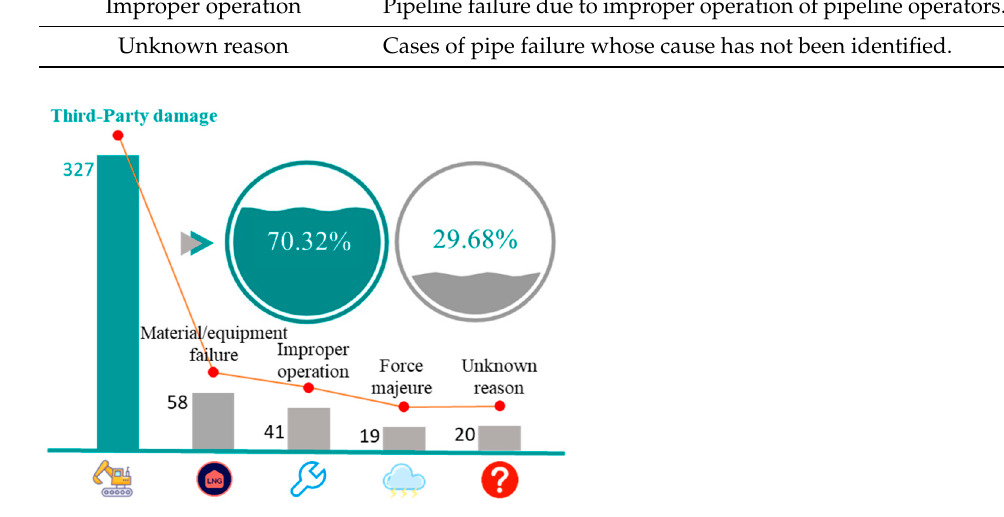
Figure 1. Statistical chart of the causes of failure of PE pipeline accidents in urban